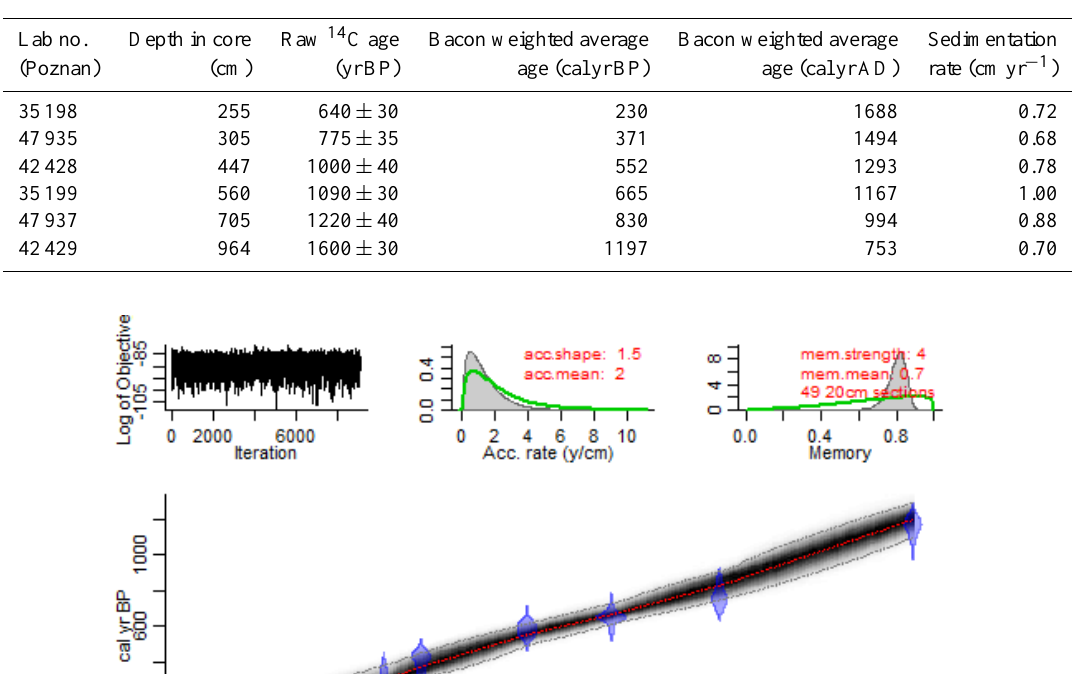
Table 1. Radiocarbon dates as obtained from the Bacon modeling.